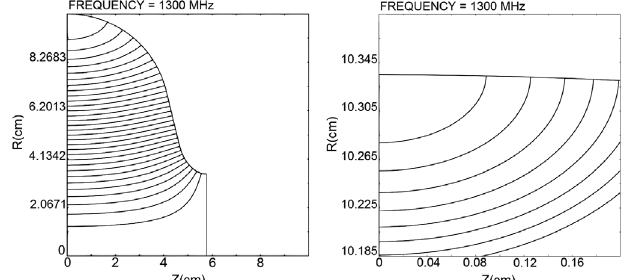
FIG. 14. Electric force lines for the entire half-cell of the TESLA cavity and near the equator. Force lines near the equator are elliptic arcs with ratio of half-axes b see text.